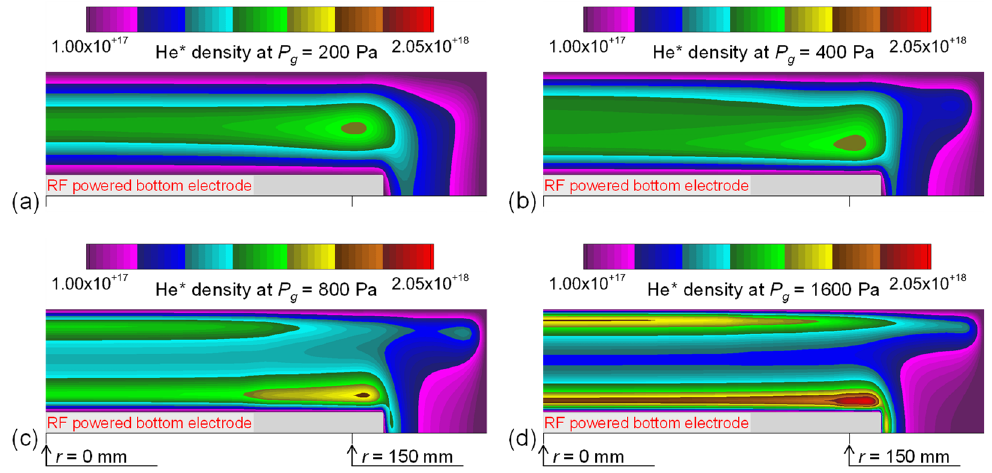
Figure 3. The spatial profiles of the time ‐ averaged He* density (m − 3 ) ( a ) for Case 1, ( b ) for Case 2, ( c ) for Case 3, and ( d ) for Case 4.